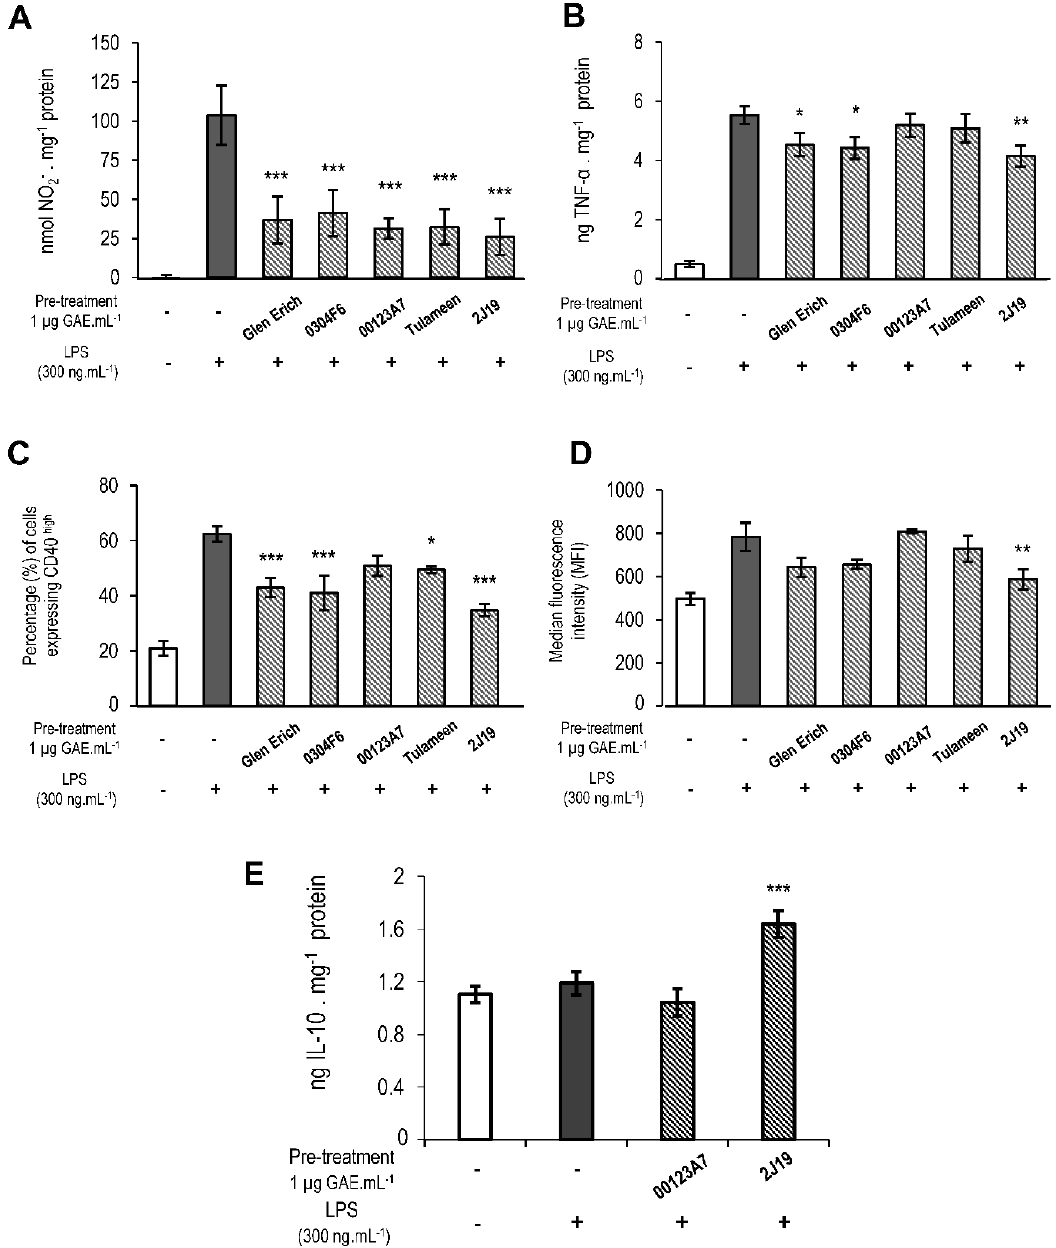
Figure 2. GIB fractions modulate microglial pro- and anti-inflammatory markers, as well as NO and superoxide. N9 microglial cells were pre-treated with each raspberry GIB fraction (1 µ g GAE · mL − 1 ) for 6 h before stimulation with LPS for 24 h. ( A ) Quantification of the NO release; ( B ) quantification of TNF- α release. ( C ) Percentage of cells that express CD40 high . ( D ) Median fluorescence intensity (MFI) of dihydroethidium (DHE) as indicator of intracellular superoxide accumulation. ( E ) Quantification of IL-10 release (only 00123A7 and 2J19 GIB fractions were analyzed). Results were normalized for the total protein in each treatment (mean ± SEM; n = 3). Solid white bars represent untreated cells (naive); solid grey bars represent LPS-stimulated cells with no GIB fraction pre-treatment (control); striped bars represent the cells pre-treated with the indicated GIB fraction before LPS stimulation. Statistical comparisons are respective to the di ff erences between the pre-treatment with each of the GIB fractions (striped bars) and the control (solid grey bars), and denoted as *** p < 0.001; ** p < 0.01 and * p < 0.05.